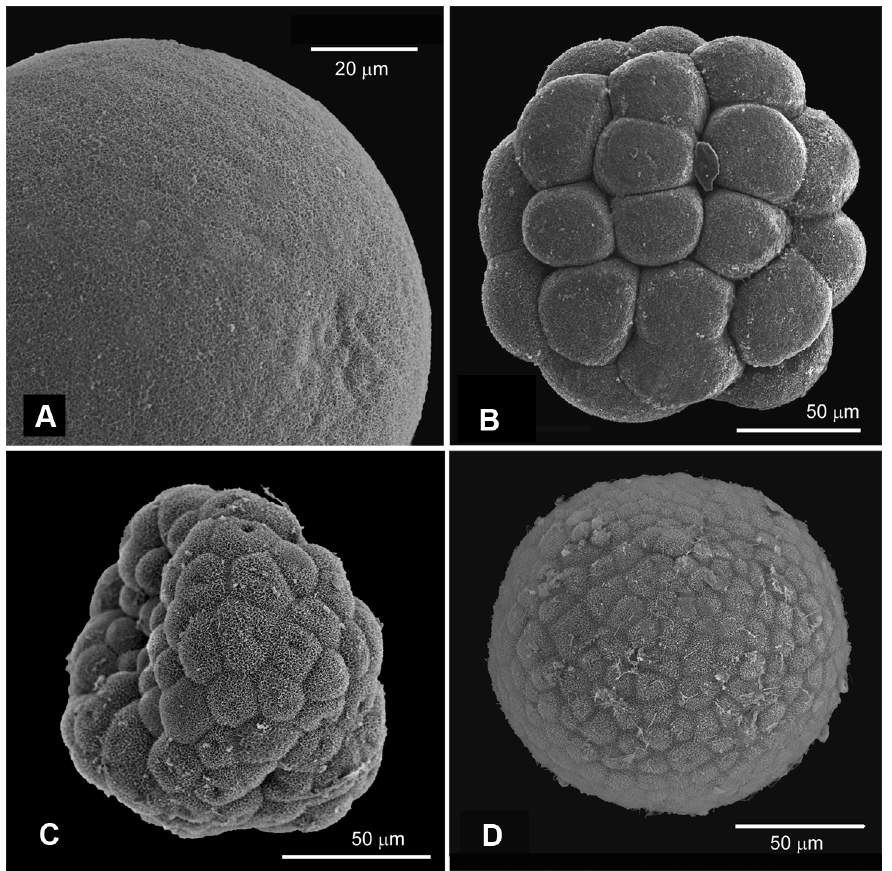
Figure 2. SEM images of Lopheliapertusa early development. ( A ) SEM image of an oocyte; ( B ) morula stage embryo; ( C ) Two days old embryo with indentation that possibly represents forming of the hollow blastula from morula stage; ( D ) late blastula showing sparse cilia coverage.